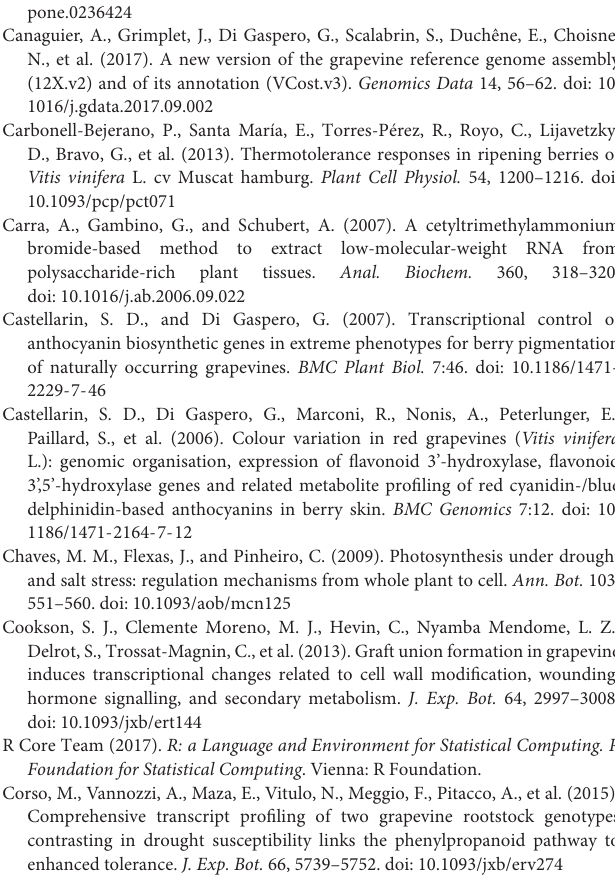
Supplementary Figure 4 | Correlation between RNA-Seq and qPCR differential expression represented as log 2 FC. R 2 = 0.83. Supplementary Table 1 | Primers and probes used for grapevine gene expression analysis. Supplementary Table 2 | Gene sets significantly enriched by GSEA. Values represent the percentages of genes that were positively ( + ) or negatively (–) regulated within a particular bin in leaves and berries of cv. Tempranillo vines grafted onto 1103-Paulsen, M1, or M4 rootstocks and subjected to salinity stress. The values are derived from comparison of control and salinity-treated plants in selected time-points. Only the values with statistical significance (FDR q value < 0.25) are listed. Red denotes positive enrichment or upregulation and green denotes negative enrichment or downregulation. The percent value represents the proportion of genes in the gene set which contributed to the enrichment. C, control; S, salinity; 1P, 1103-Paulsen rootstock; M1, M1 rootstock; M4, M4 rootstock; L, leaves; B, berries. Supplementary Table 3 | High-throughput RNA-Seq of salinity- treated grapevine berry skin and leaf samples cv. Tempranillo grafted onto 1103-Paulsen, M1, and M4. C, control; S, salinity; 1P, 1103-Paulsen rootstock; M1, M1 rootstock; M4, M4 rootstock; L, leaves; B,